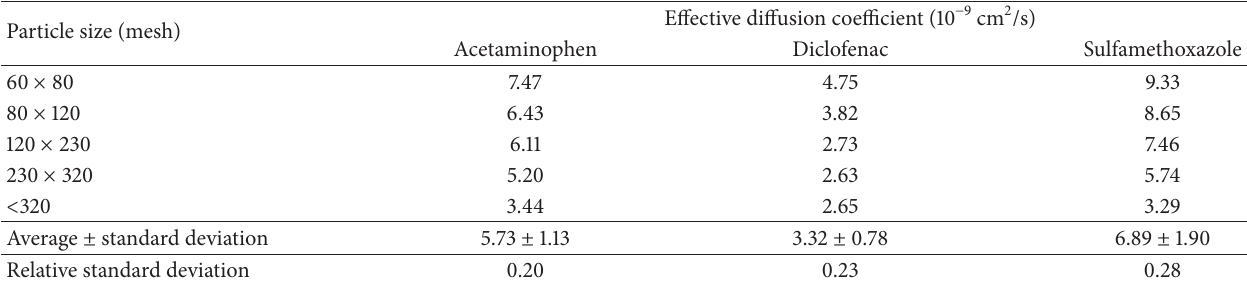
Relative standard